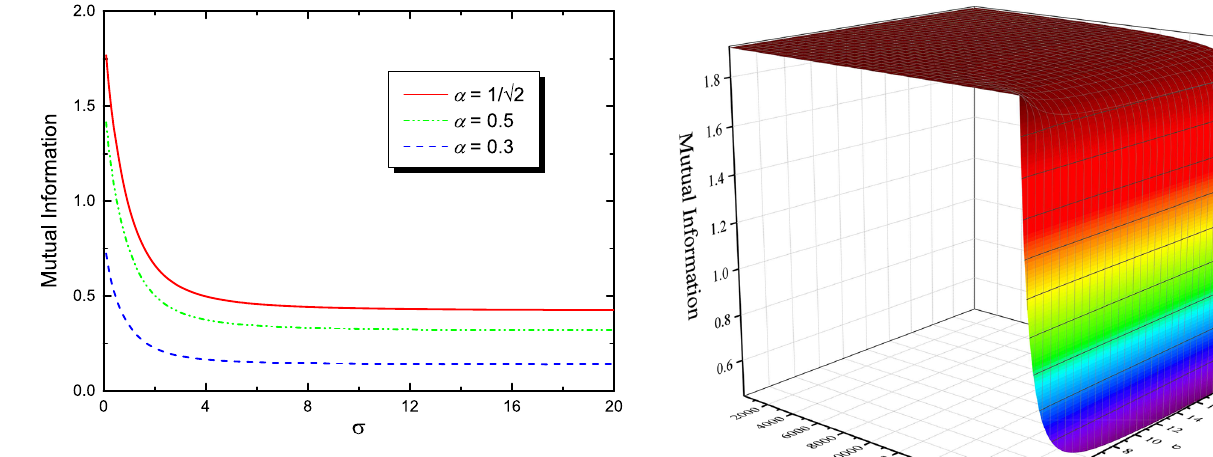
Fig. 5 The mutual information I of the final state of two entangled qubits as a function of the rapidity σ of the expansion of the spacetime. The parameters of the two qubits are the same. The qubit energy level difference is (cid:15) = 2, the inner product of the mode functions, defined in Eq. (21), is μ = 0 . 1, the mass of the scalar field particle is m = 0 . 01. The volume of the expansion is chosen to be ε = ε max = 19 , 999 . 5. The initial state of the qubits is α | 01 (cid:7) + β | 10 (cid:7) √ For α = 1 / 2, the 2D plot of the mutual information as a function of the two parameters ε and σ is shown in Fig. 6.